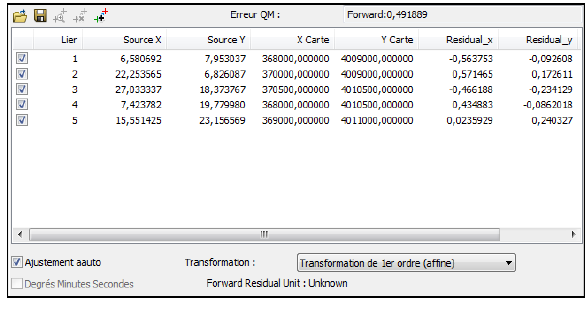
Figure 5. Example of Georeferencing accuracy